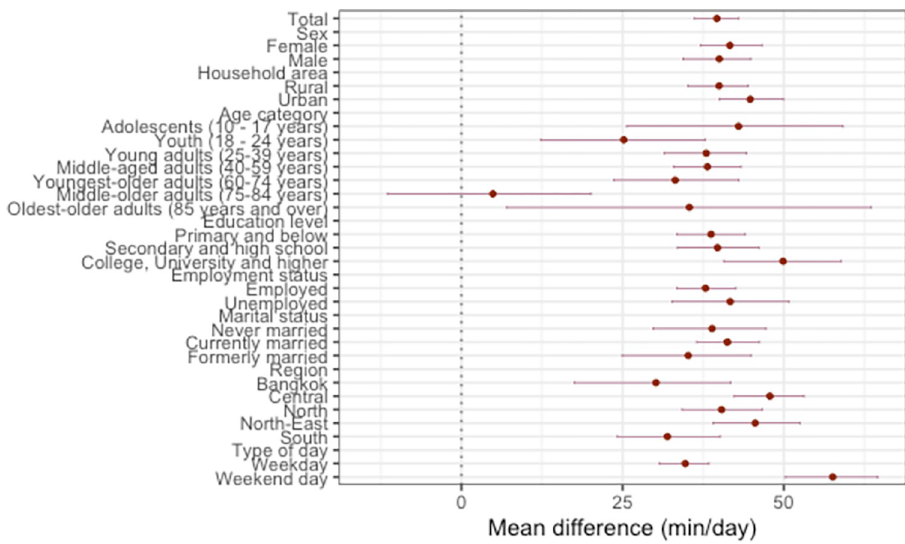
Fig 3. Mean difference in sedentary behaviour from 2009 to 2015. Mean changes in sedentary behaviour from 2009 to 2015 (circles) and their 95% bootstrap confidence intervals (whiskers).